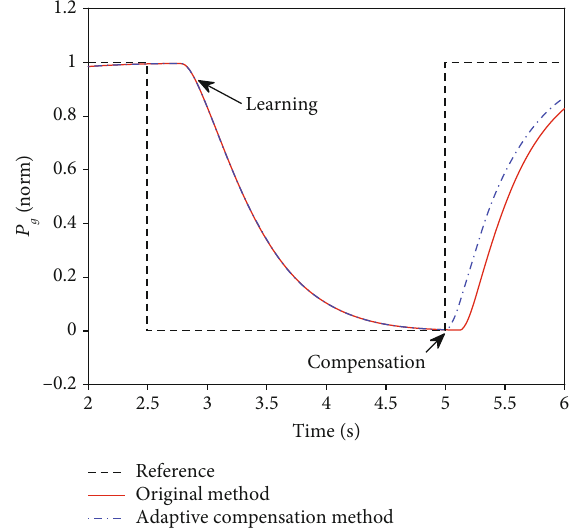
Figure 18: Result of the motor angle and the valve angle by an adaptive compensation